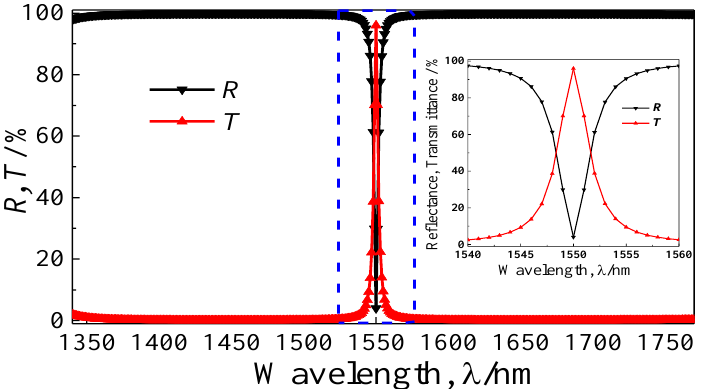
Figure 2. The full drawing and the inset detail enlarged drawing of the simulated reflectance ( R ) and transmittance ( T ) spectra of the designed quasi-one-dimensional PC with (Nb 2 O 5 /SiO 2 ) 6 (SiO 2 /Nb 2 O 5 ) 6 .